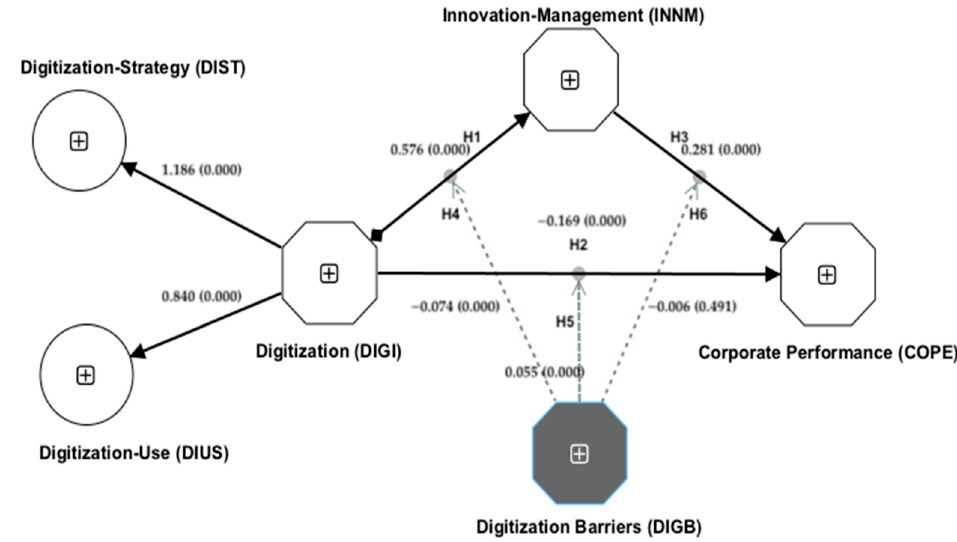
Figure 2. Nomogram of this study (test moderation analysis).